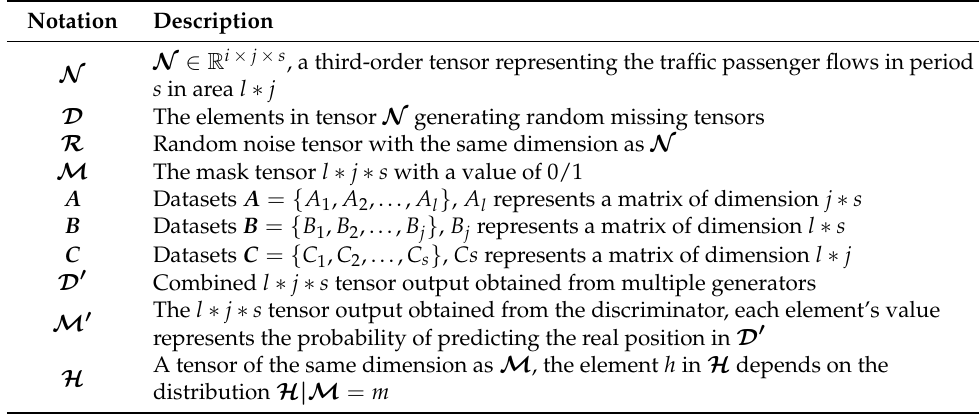
Table 1. Notations used in the ST-GAIN